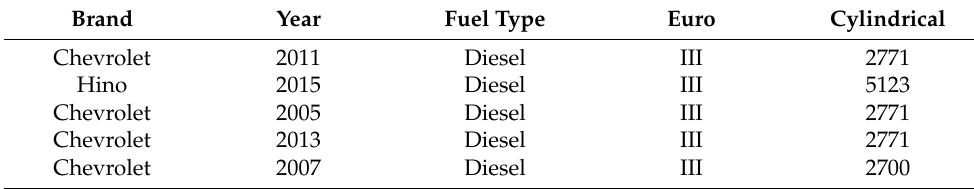
Table 3. Vehicle